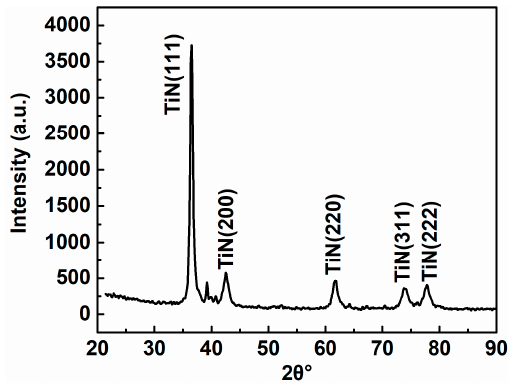
Figure 3. XRD di ff raction pattern of the TiN / Ti multilayer coating. Figure 3. XRD diffraction pattern of the TiN/Ti multilayer coating. Figure 3. XRD diffraction pattern of the TiN/Ti multilayer coating.